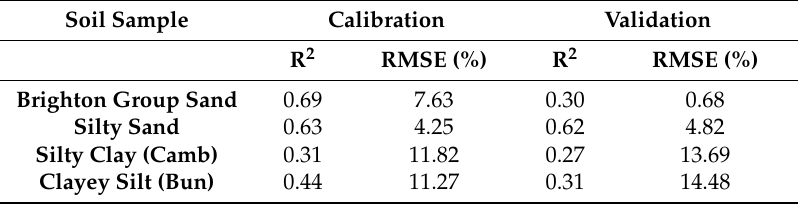
Table 3. Cross validation analysis for the Circular sensor for each